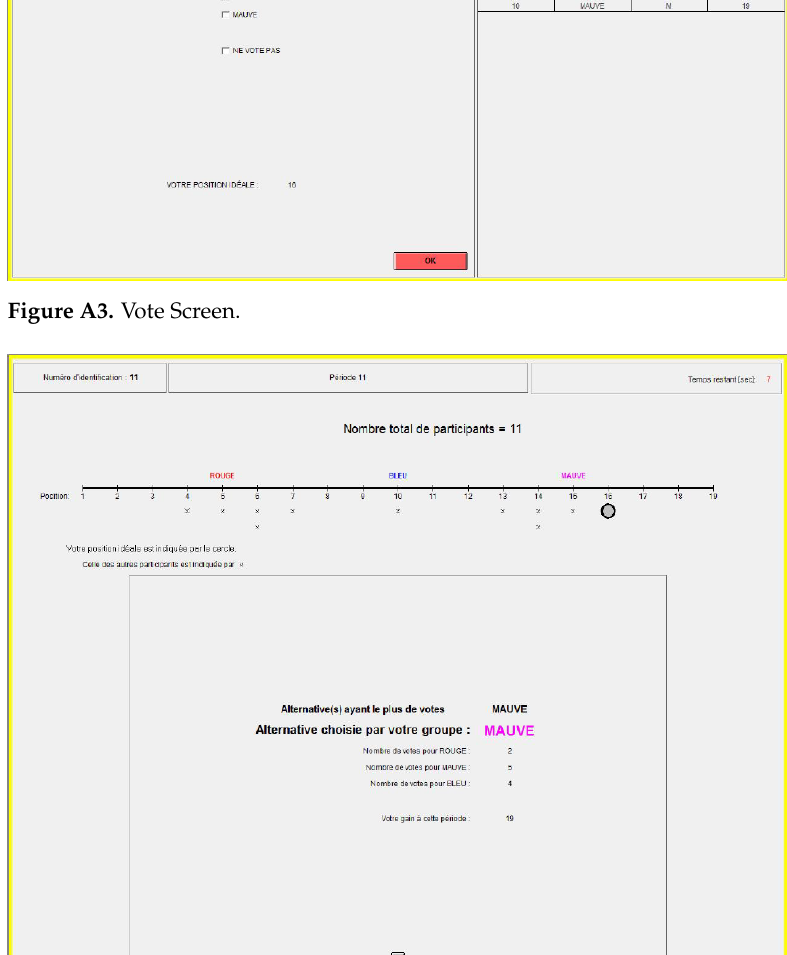
Figure A4. Result